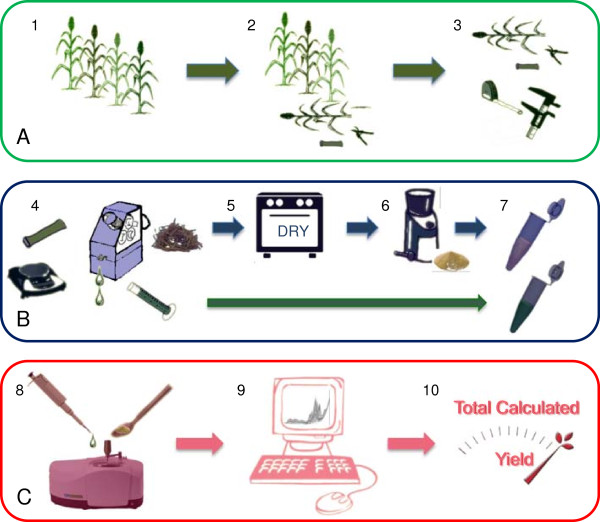
High-throughput methodology flow chart. (A) (1) Diverse plant population; (2) harvest the fourth internode; and (3) record in-field geometric measurements. (B) (4) Process into juice and bagasse; (5) dry bagasse; (6) grind dried tissue; and (7) process juice and bagasse. (C) (8) Collect FTIR spectra; (9) PLS prediction of FTIR spectra; and (10) calculate combined total fermentable sugar yield incorporating juice volume (V), sugar concentration ([S]), biomass (B), and digestibility (D) (see Additional file 1 for full protocol). FTIR, Fourier transform infrared; PLS, partial least squares.